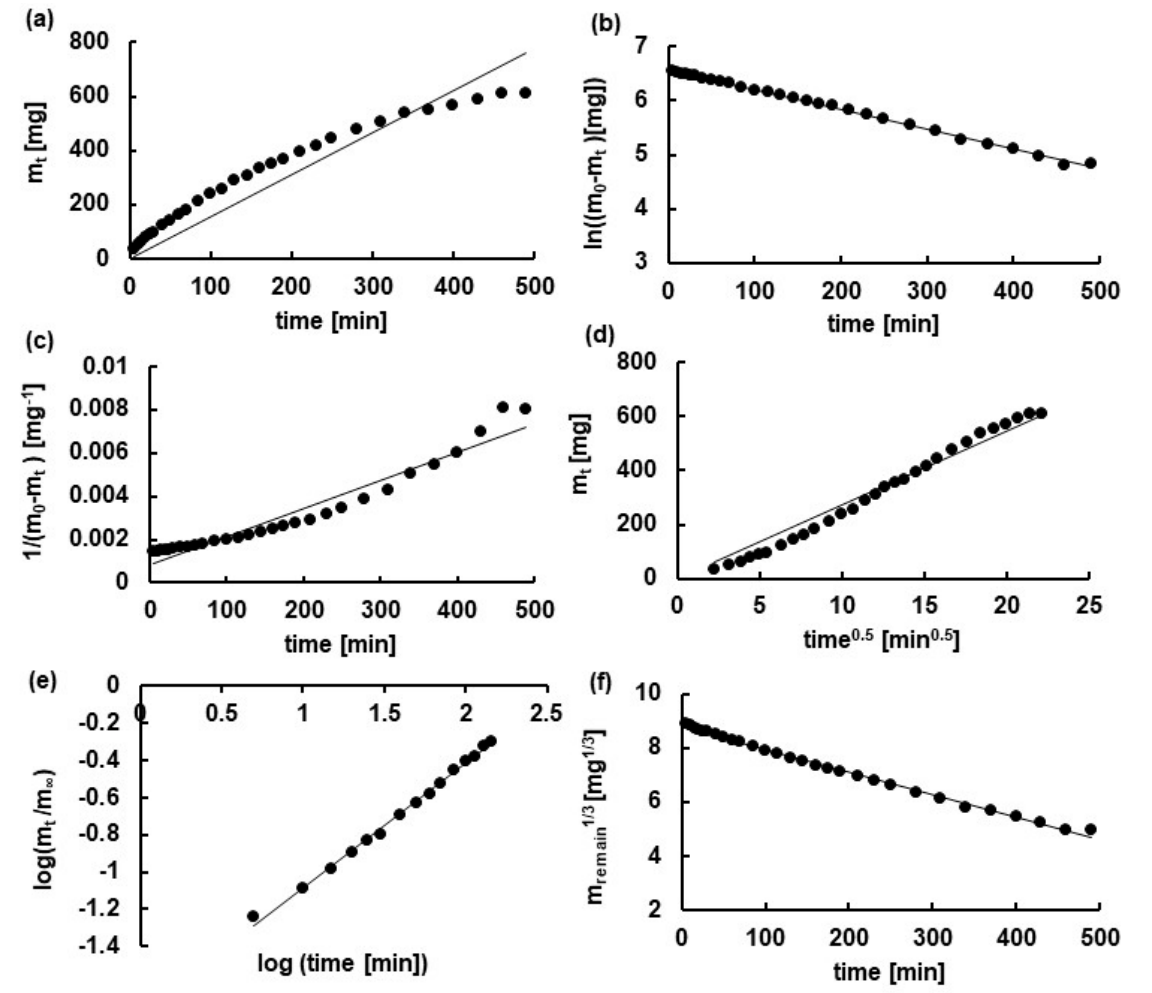
Figure 7. The theoretical plots (lines) fitted to the experimental data (points) obtained for the release of N from formulation F9; ( a ) zero-order model, ( b ) first-order model; ( c ) second-order model; ( d ) Higuchi model; ( e ) Korsmeyer-Peppas model; ( f ) Hixon-Crowell model.